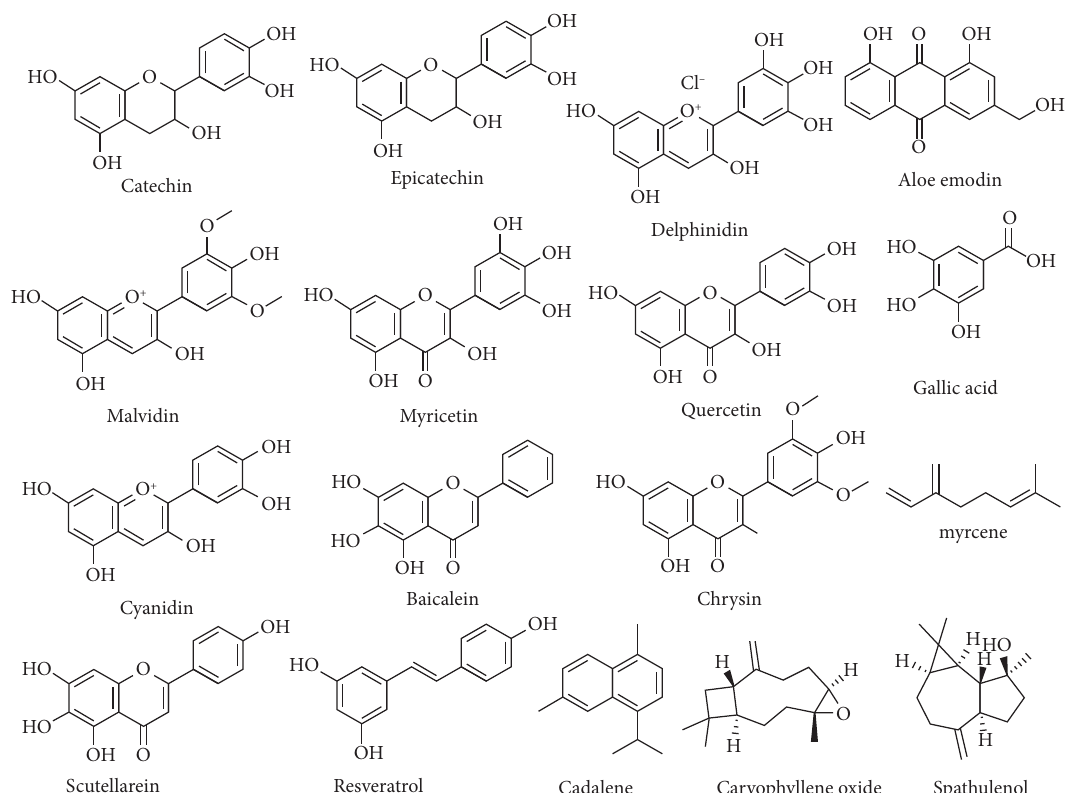
Figure 1: Chemical structure of some secondary metabolites present in the collected